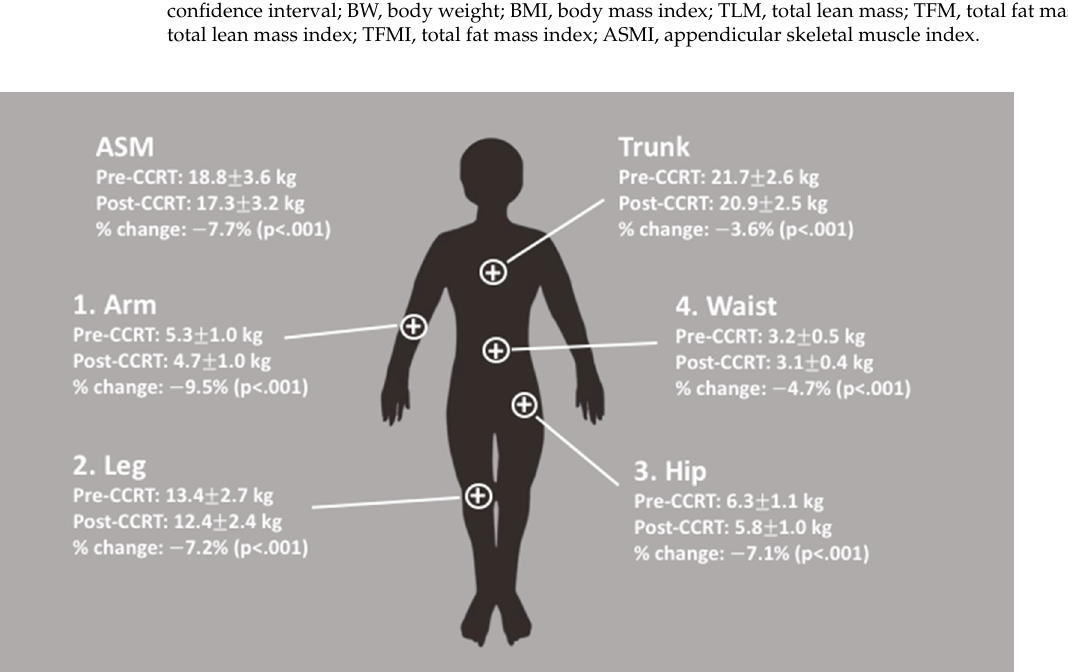
Figure 2. Details on the lean mass loss during CCRT. There was an asynchronous loss of lean mass in different body regions, with the highest loss of lean mass during CCRT observed in the arms, followed by the legs, hips, waist, and trunk. This suggests that CCRT had a higher impact on the lean mass of peripheral extremities (i.e., the appendicular skeletal muscle [ASM]) than on the central region (trunk) of the body.